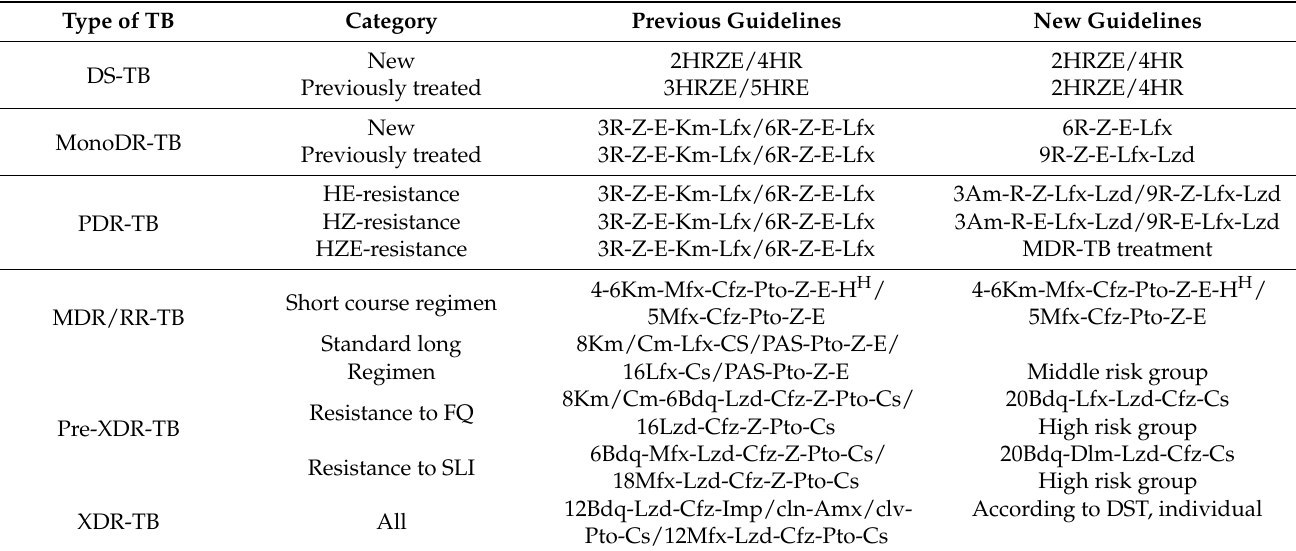
Table 1. TB treatment regimens used in